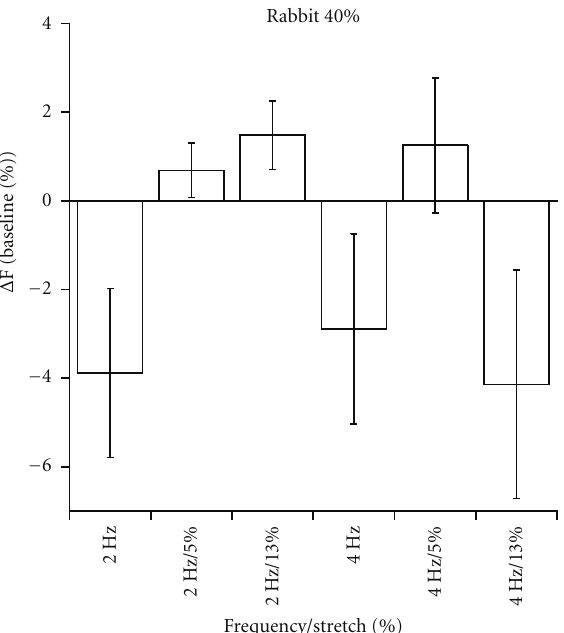
Figure 3: At a variability of 40% in the rabbit at both 2 and 4Hz, there was no statistically significant di ff erence between variable and base protocols. The addition of a 5% and/or 13% stretch just prior to contraction did not seem to improve or impair the average force